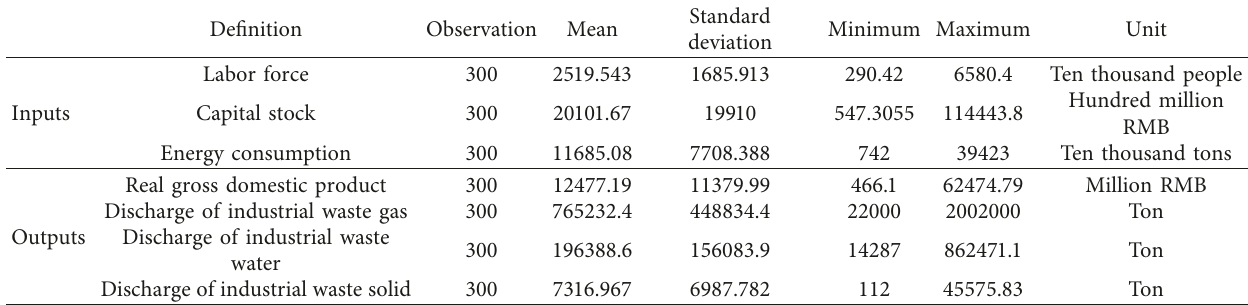
Table 1: Input-output factors’ definitions and descriptive statistics.